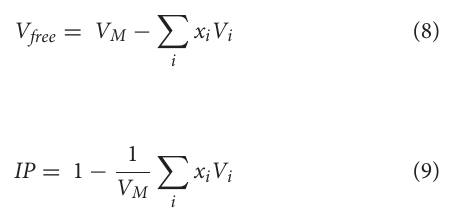
Figure 3A shows the isothermal permeability of